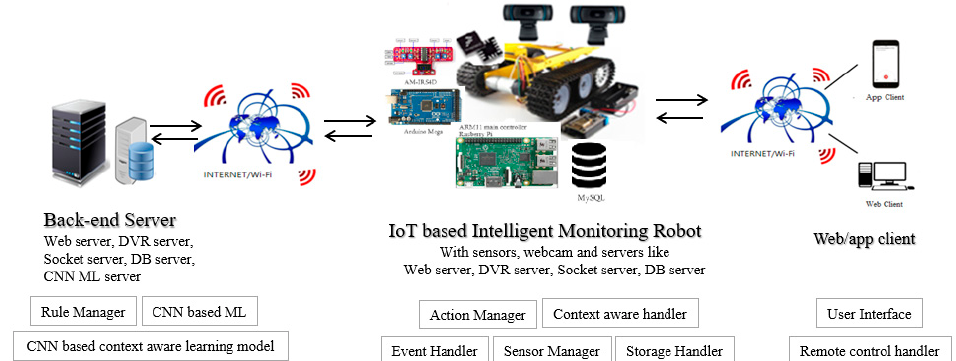
Figure 4. Architecture of the IoT platform with monitoring robot applying CNN machine learning (ML).